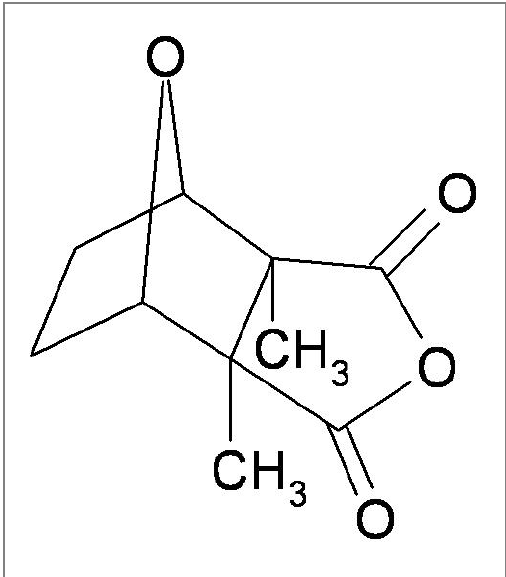
Figure 3. Cantharidin chemical structure.